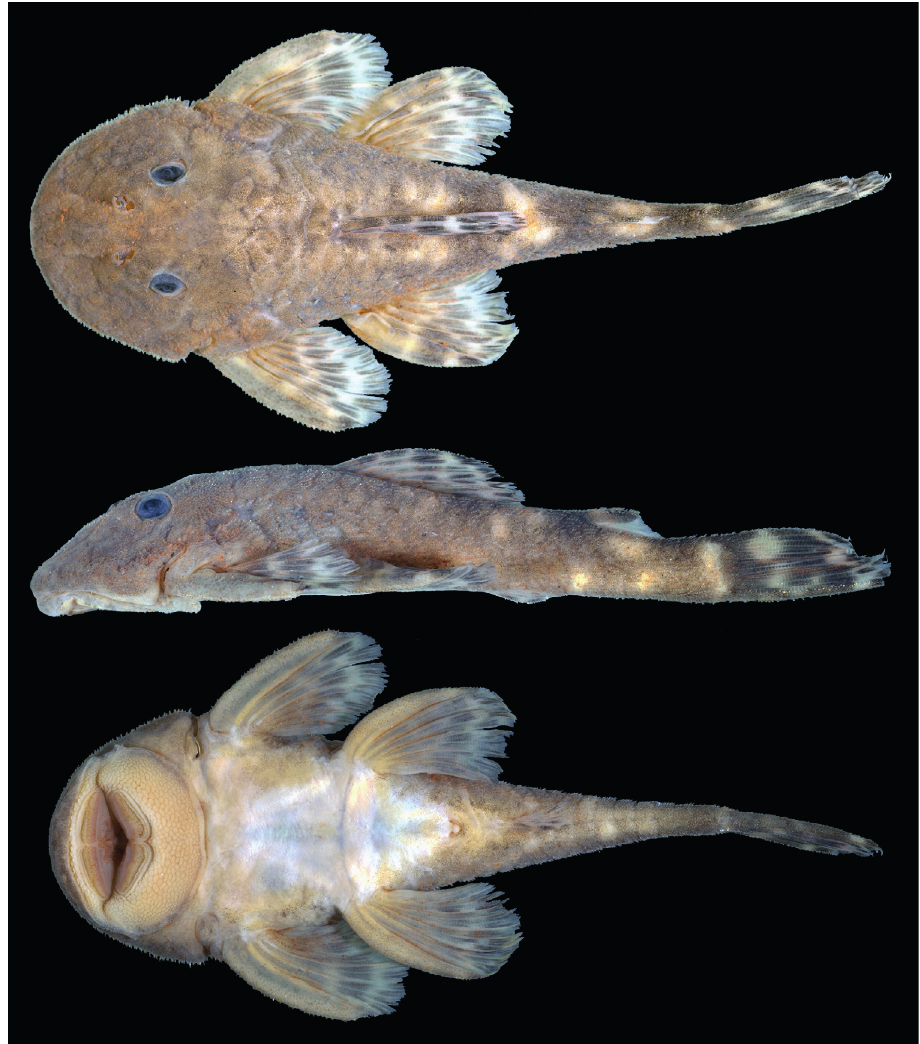
FIGURE 1 | Pareiorhaphis pumila , holotype, MCP 54782, 48.2 mm SL, male, rio Ijuí below dam of Passo de São José hydropower reservoir, Cerro Largo, Rio Grande do Sul,